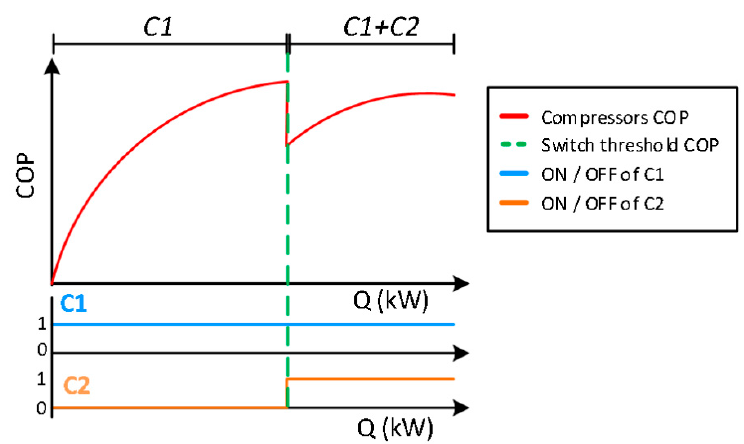
Figure 4. Example of the performance of two screw compressors C1 and C2 working in parallel to supply the cooling demand.